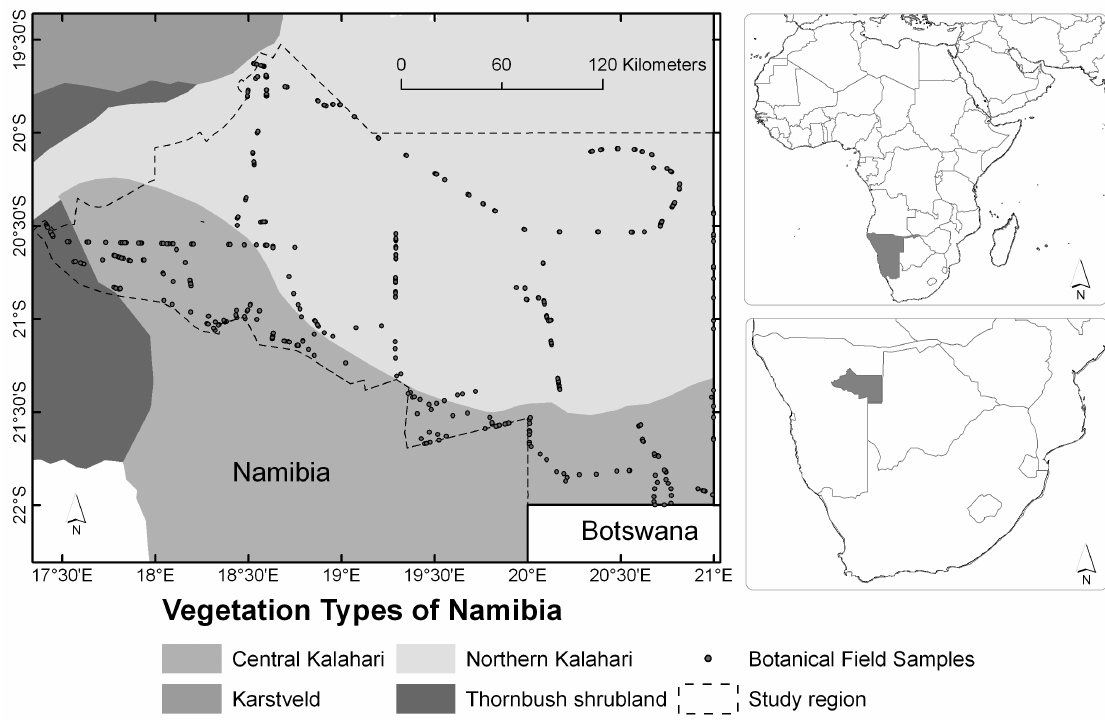
Figure 1. Overview of the study region in communal areas in the Namibian Eastern Kalahari showing the main savanna vegetation types after Giess [4] overlain with the distribution of botanical field samples